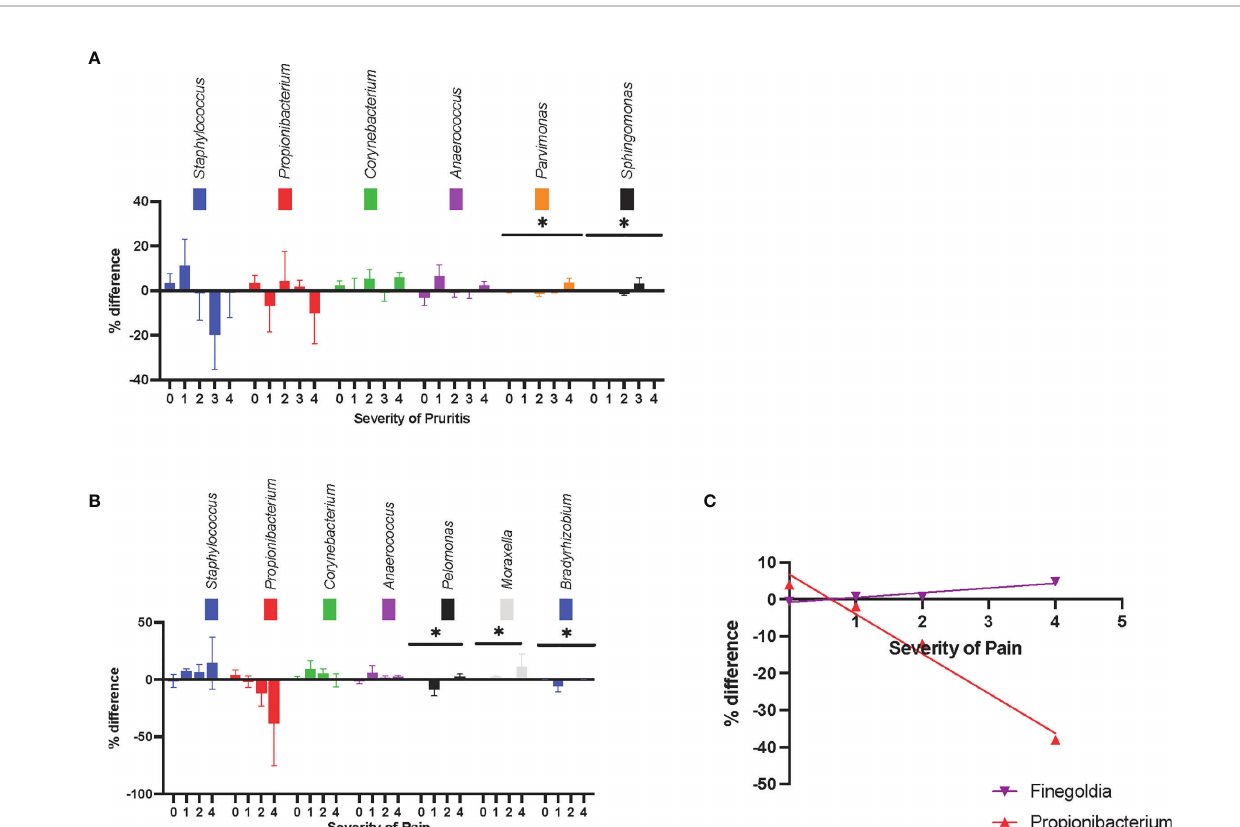
FIGURE 3 | Symptom-associated changes in skin microbiota composition at the genus level. (A) The changes in relative abundance were shown at different pruritus level. (B) The changes in relative abundance were shown at different pruritus level, Pelomonas spp., Moraxella spp., and Bradyrhizobium spp. had statistically signi fi cant difference between pain levels. There was a trend that Staphylococcus spp. became more abundant and Propionibacterium spp. became less abundant, as the pain level increases. (C) The increase in the relative abundance of Propionibacterium spp. was negatively correlated with pain intensity. The increase in the relative abundance of Finegoldia spp. in lesional skin was positively correlated with pain intensity. *P ≤